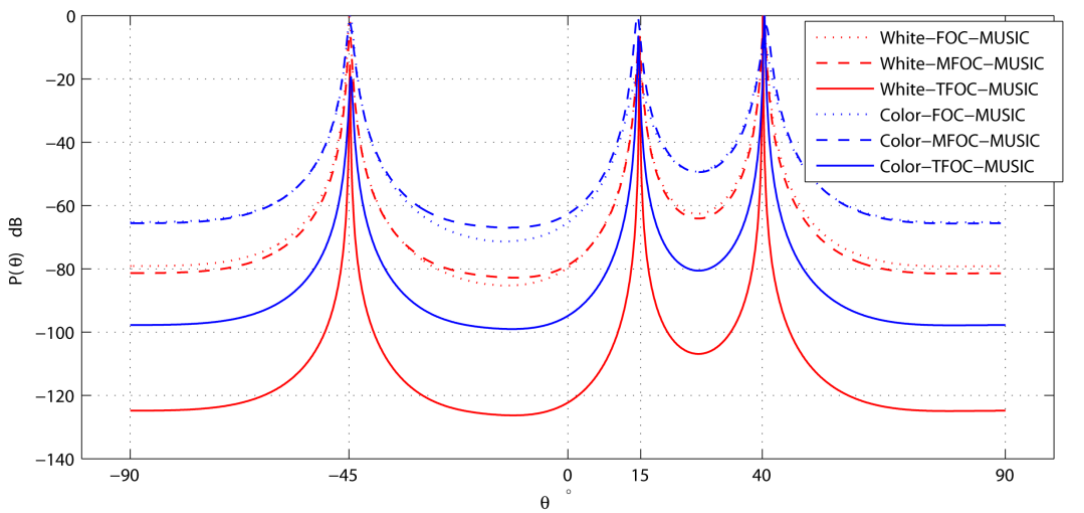
Figure 1. Spatial spectrum comparisons versus